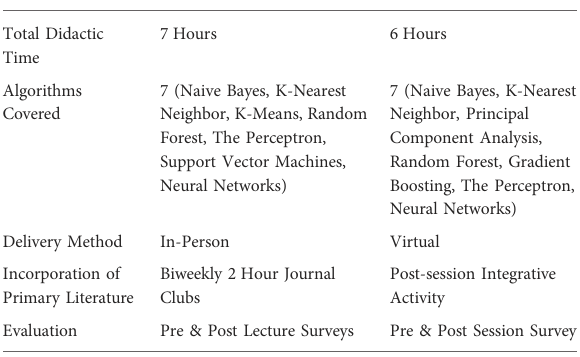
TABLE 1 Comparison of the 7 month and One-Day intensive AI-RADS